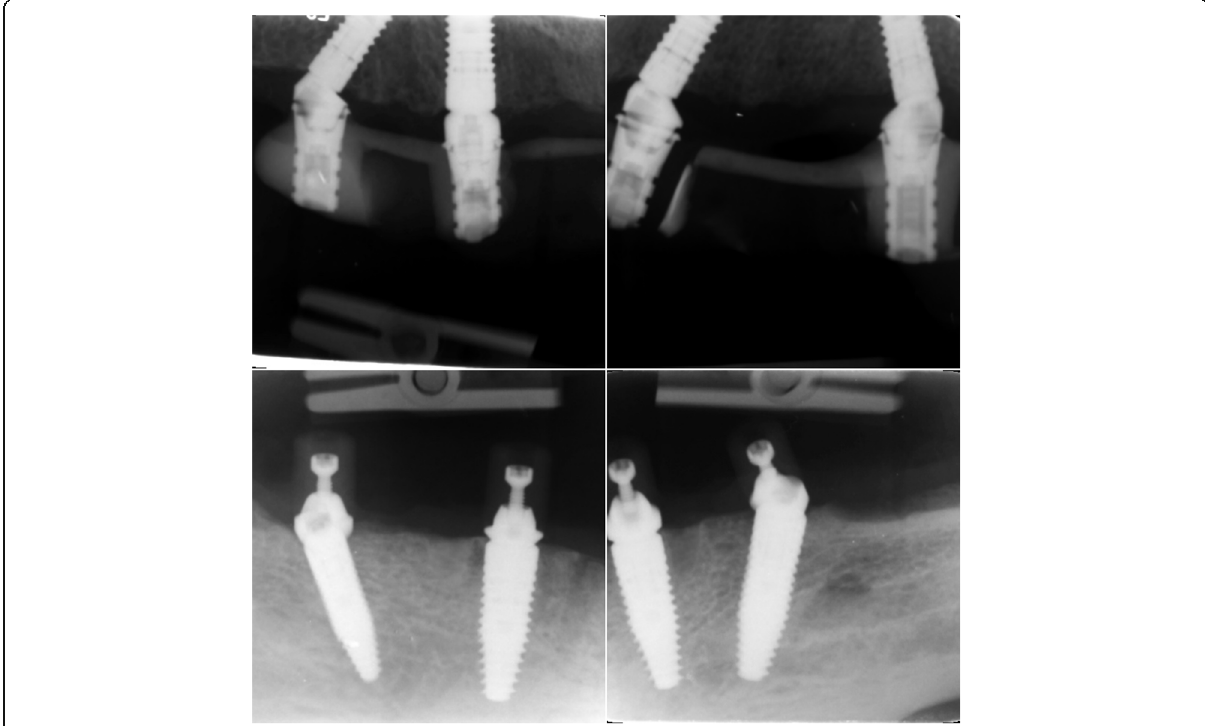
Fig. 7 Radiological follow-up of patient was performed with paralleling